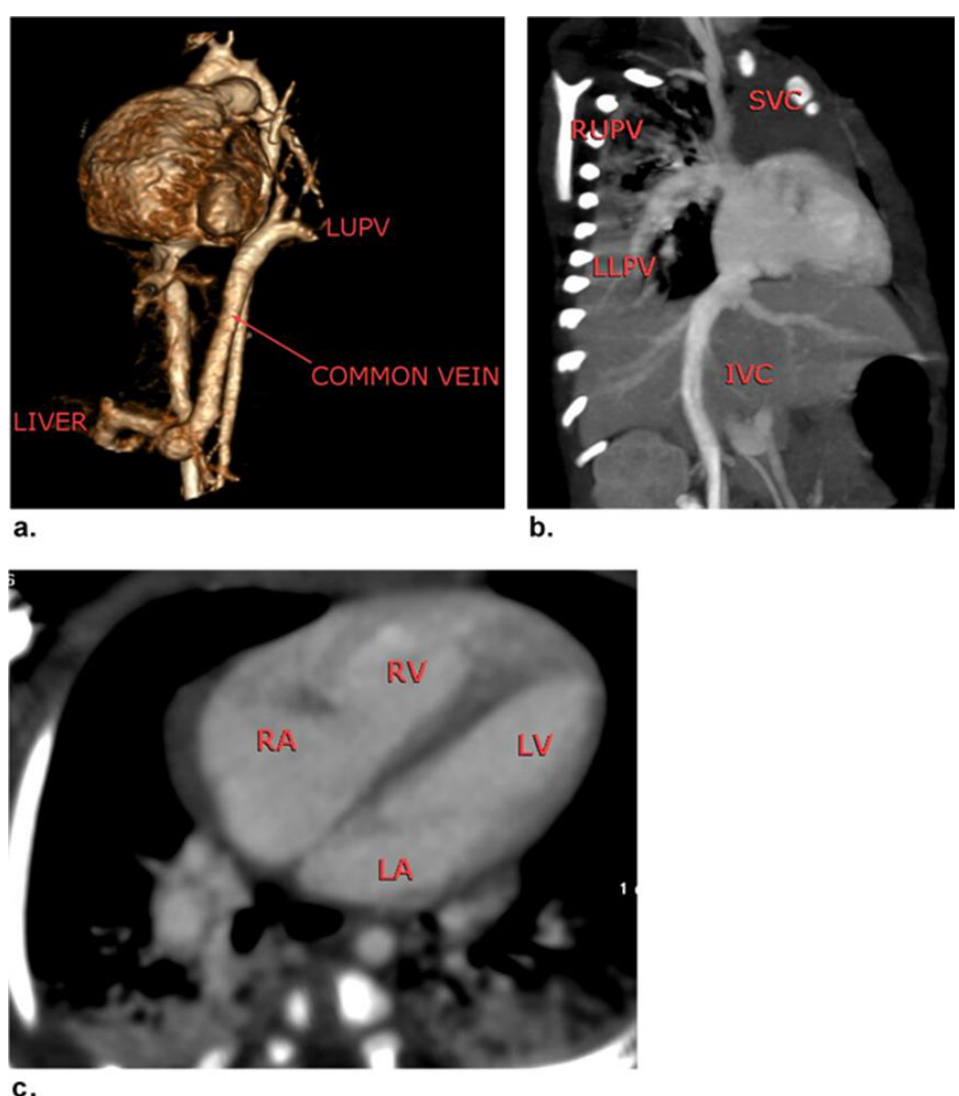
Figure 3. A one-month-old female patient with total anomalous pulmonary venous return (right side → SVC/left side → common vein → portal vein). ( a ) Coronal 3D-VR image revealing left upper and lower pulmonary veins communicated to form one common vein passing downward right to the aorta to join the portal vein after a 40 mm course and a 90-degree angle curve. ( b ) Curved MIP image revealing right upper and lower pulmonary veins joined at the entry site at the base of the SVC just beside the junction of a large azygous vein. ( c ) Axial MIP image revealing patent foramen ovale of 3 mm with a right to left shunt. There was no pulmonary vein connection to the left atrium.